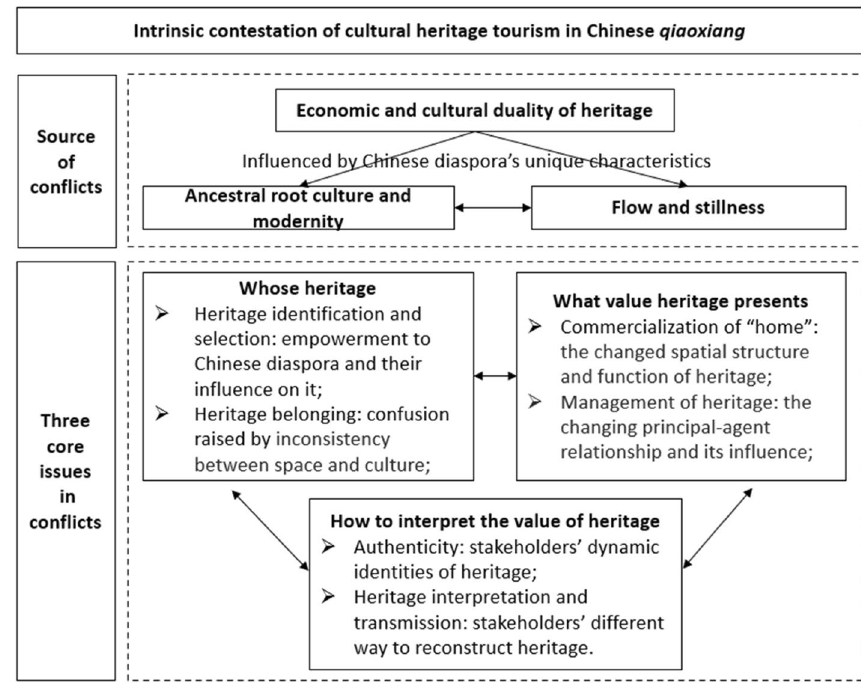
Fig. 1 A framework for the intrinsic contestation of cultural heritage tourism in Chinese qiaoxiang. (Source: the